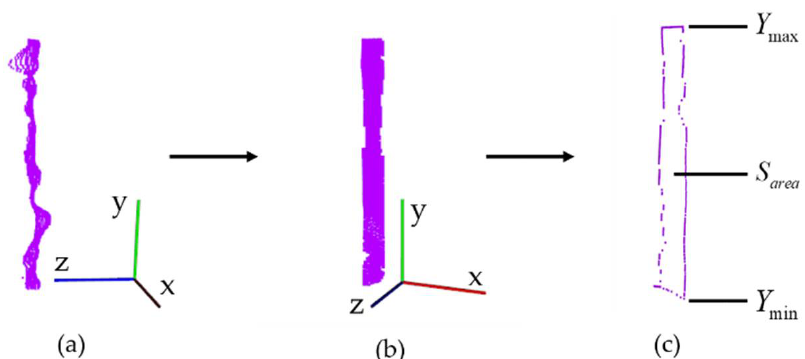
Here, W stem is the stem diameter, S area is the polygon area of the point cloud on the X- Y projection plane, and the Y max and Y min represent the maximum and minimum values on the X -axis for 2D point cloud coordinates, respectively. Figure 7. The point cloud with outliers. Figure 7. The point cloud with outliers.